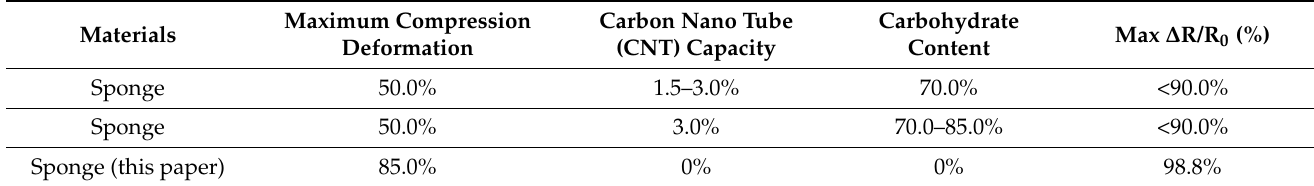
Table 1. Comparisons of the sensors’ performance.